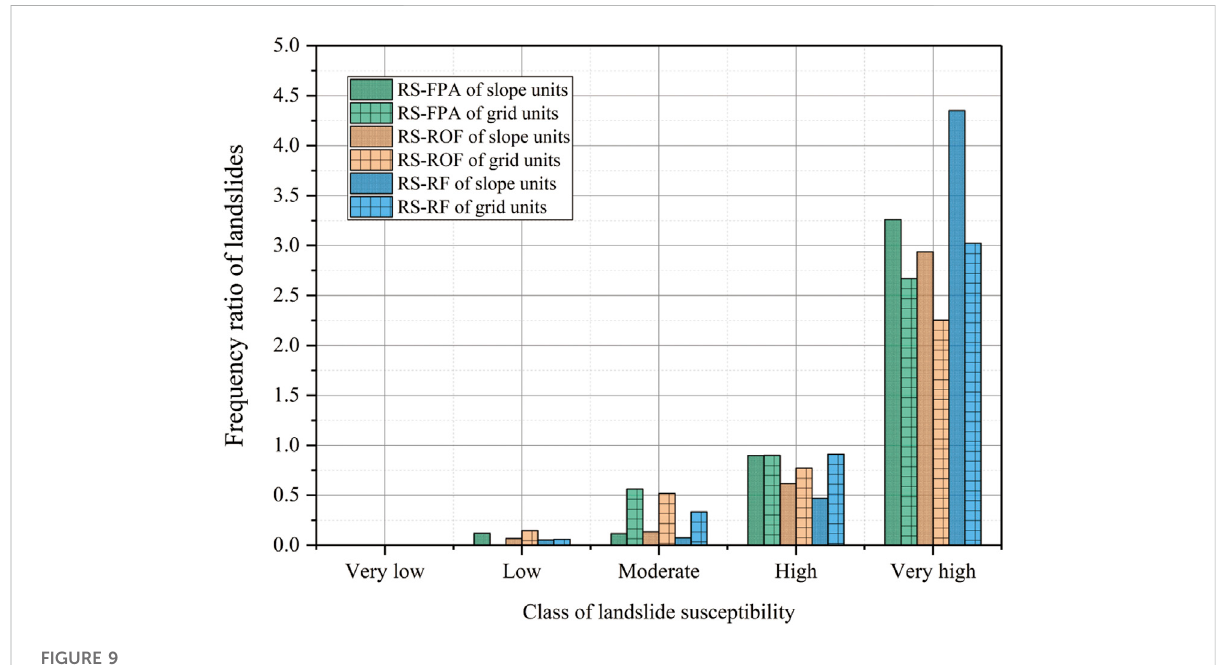
FIGURE 9 Comparison of the frequency ratios of three